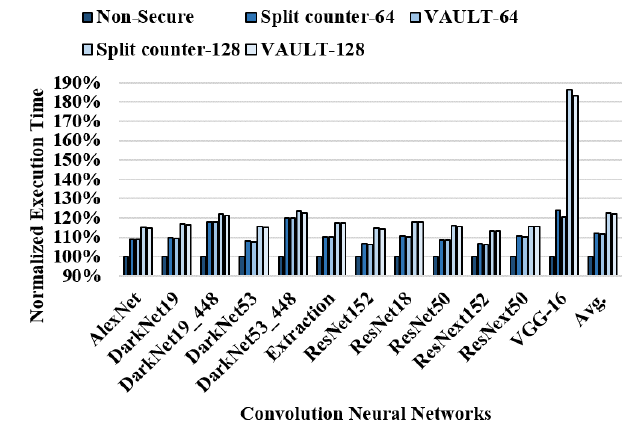
Figure 9. Normalized execution time for split counter-64, VAULT-64, split counter-128, and